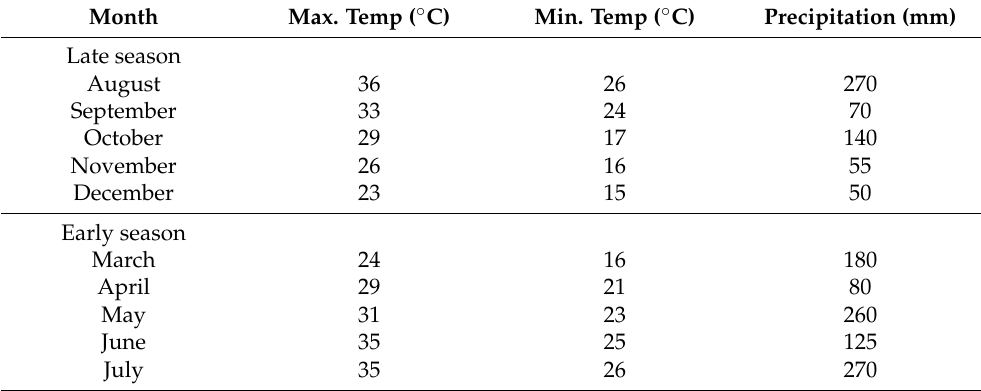
Table 1. Maximum and minimum temperature and rainfall at the experimental site. Month Max. Temp ( ◦ C) Min. Temp ( ◦